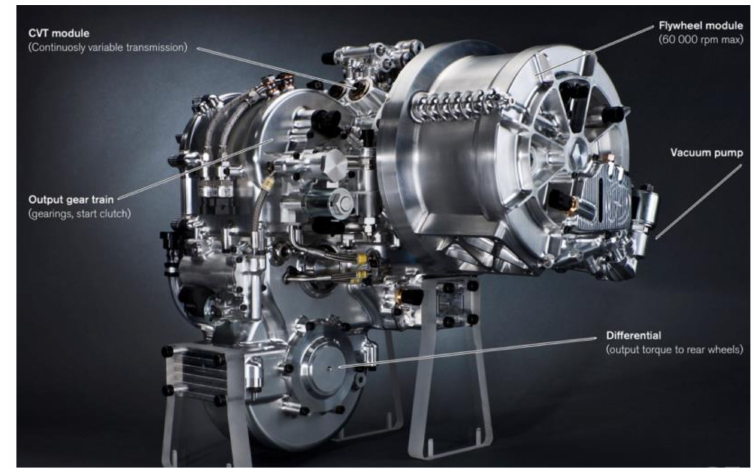
Figure 19. S60 Sedan volvo flywheel, adapted from [132].